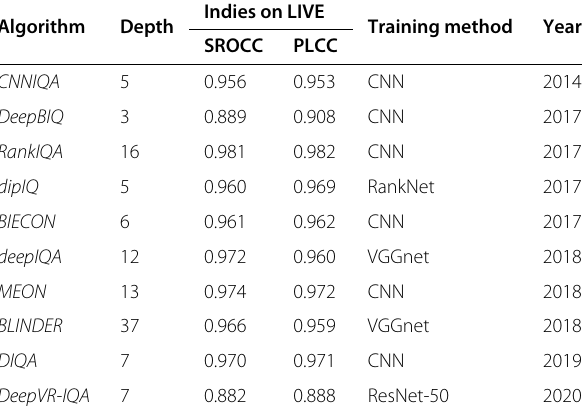
Table 2 Implicit NR-IQA algorithm performance